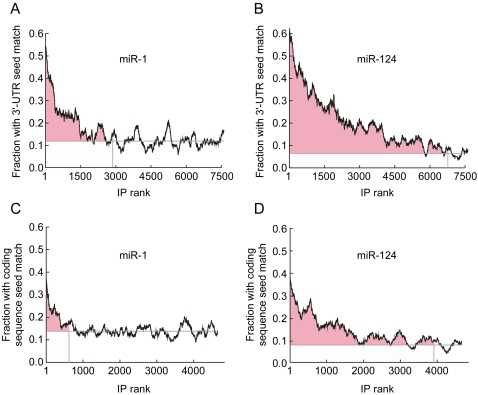
Estimation of the number of miR-1 and miR-124 targets.(A) Moving average plot (window size of 200) of the fraction of mRNAs with 7mer 3′-UTR seed matches to miR-1. mRNAs were ranked by their SAM enrichment in Ago2 IPs in the presence of miR-1 compared to Ago2 alone, with 1 corresponding to the most enriched mRNA. To determine the point at which the curve first rose above the background level of 7mer seed matches, we first calculated the slope of each least-squares-fit regression line between the right-hand end of the distribution and every point to left of it. The point at which the curve first rose above the background level of 7mer seed matches was determined as the point at which the slope was first negative (vertical grey line). The fraction of mRNAs containing 7mer seed matches to the right of the vertical grey line was considered to be the background level of 7mer seed matches (horizontal grey line). To estimate the total number of targets (pink shaded region), the number of mRNAs to the left of the vertical grey line (3071 of 7805) was multiplied by the fraction of mRNAs to the left of the vertical line containing 7mer 3′-UTR seed matches (0.23) minus the fraction of mRNAs to the right of the vertical line containing 7mer seed matches (0.12). This results in an estimate of 325 targets. (B) Same as in (A), but for miR-124. 6393 of 7817 mRNAs were to the left of the vertical grey line. The fraction of mRNAs with 7mer 3′-UTR seed matches to the left of the grey vertical line was 0.21, while the fraction of mRNAs with 7mer seed matches to the right of the grey vertical lines was 0.07. This results in an estimate of 1000 targets. (C) Same as in (A), except moving average plots of the fraction of mRNAs with 7mer coding sequence seed matches to miR-1. mRNAs with 6mer 3′-UTR seed matches were removed, leaving 4855 mRNAs. 820 mRNAs were to the left of the vertical grey line. The fraction of mRNAs with 7mer seed matches to the left and right of the grey vertical line was 0.24 and 0.14 respectively. This results in an estimate of 83 targets. (D) Same as in (C), but for miR-124. 3312 of 3916 mRNAs were to the left of the vertical grey line. The fraction of mRNAs with 7mer seed matches to the left and right of the grey vertical line was 0.15 and 0.08 respectively. This results in an estimate of 236 targets.